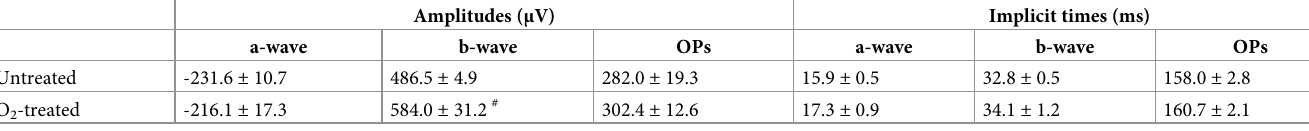
Table 3. ERG data (average of left and right eyes) from untreated and 30% O 2 -treated DBA/2J mice at 9 months of age (mean ±